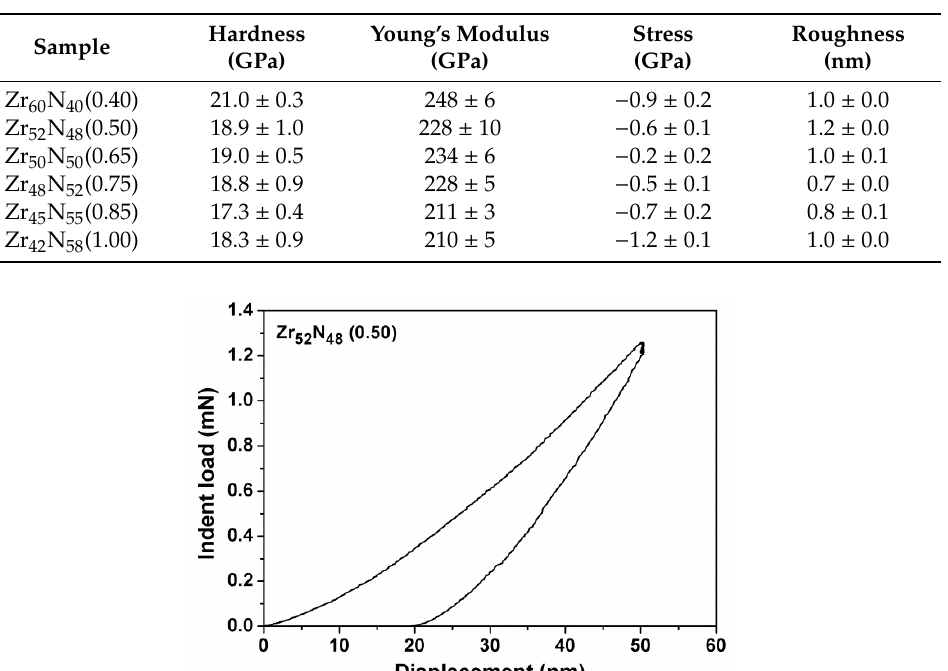
Table 3. Mechanical properties and surface roughness values of ZrN x films.